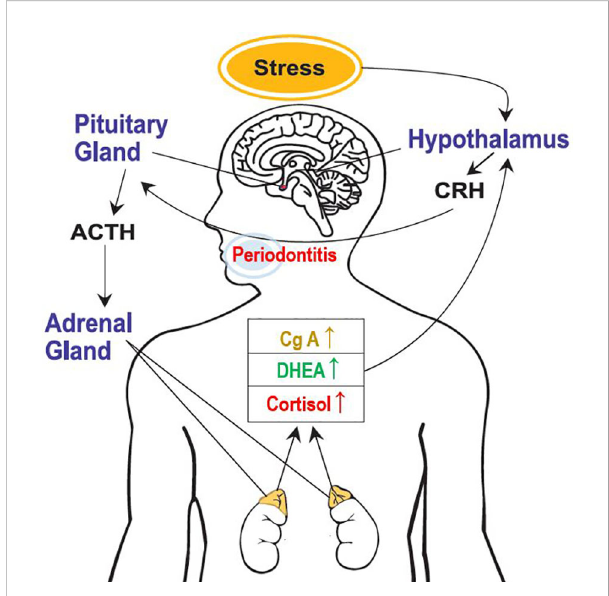
FIGURE 3 Activation of the hypothalamic-pituitary-adrenal axis because of psychological stress. CRH, corticotropin-releasing hormone; ACTH, adrenocorticotrophic hormone; DHEA, dehydroepiandrosterone; and CgA, chromogranin A.